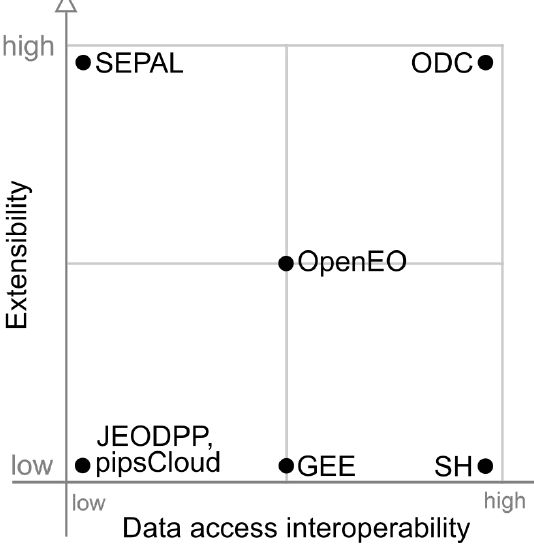
Figure 12. Data access interoperability vs.